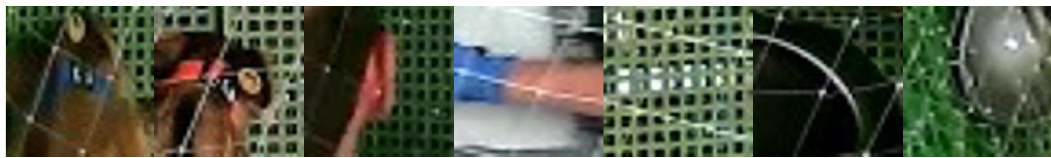
Figure 4. Samples of 227 × 227 × 3 pictures for training AlexNet. From left to right: orange collar, blue collar, ear of a veterinarian, a forearm, gridded ground and eating/drinking drinking troughs. All these objects show blue/orange connected pixels, then objects to be